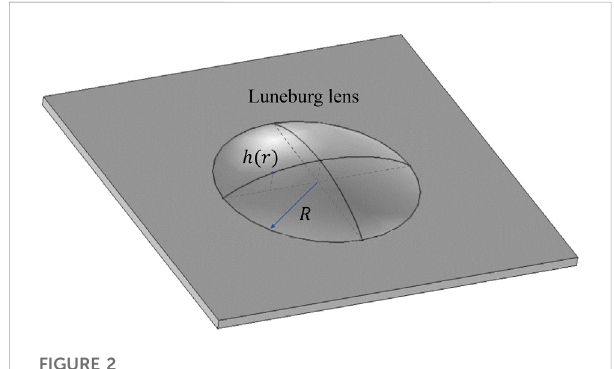
FIGURE 2 Schematic of the Luneburg lens designed for focusing the higher-order Lamb waves.